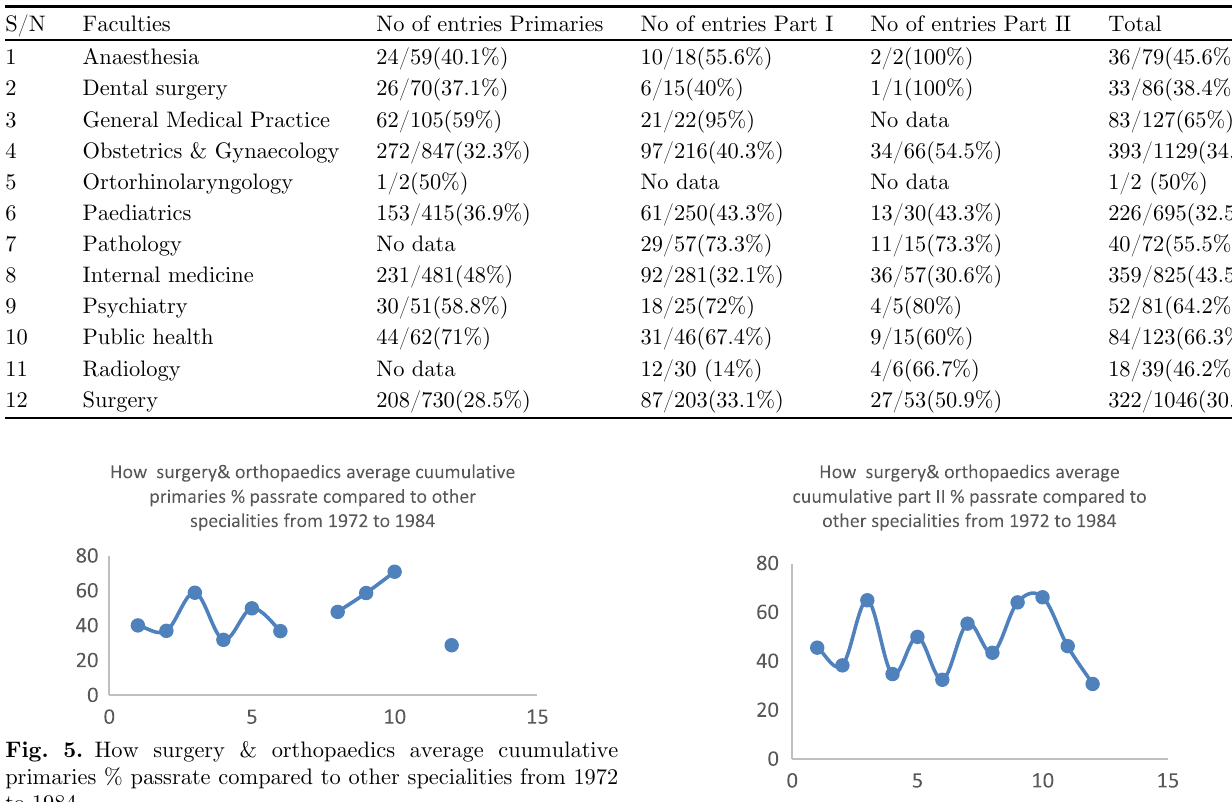
Fig. 7. How surgery & orthopaedics average cuumulative part II % passrate compared to other specialities from 1972 to 1984.